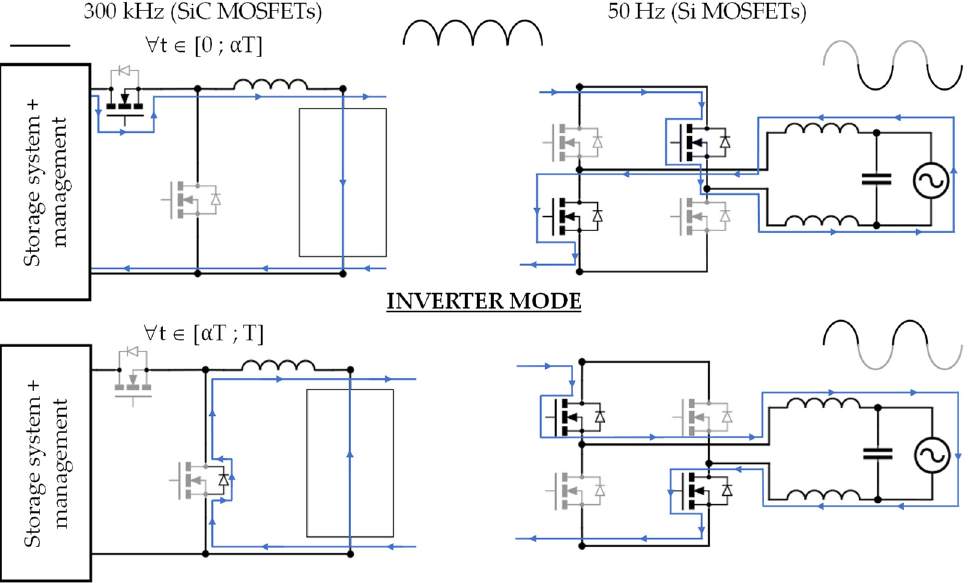
Figure 3. Schematic diagram of the converter in inverter mode.